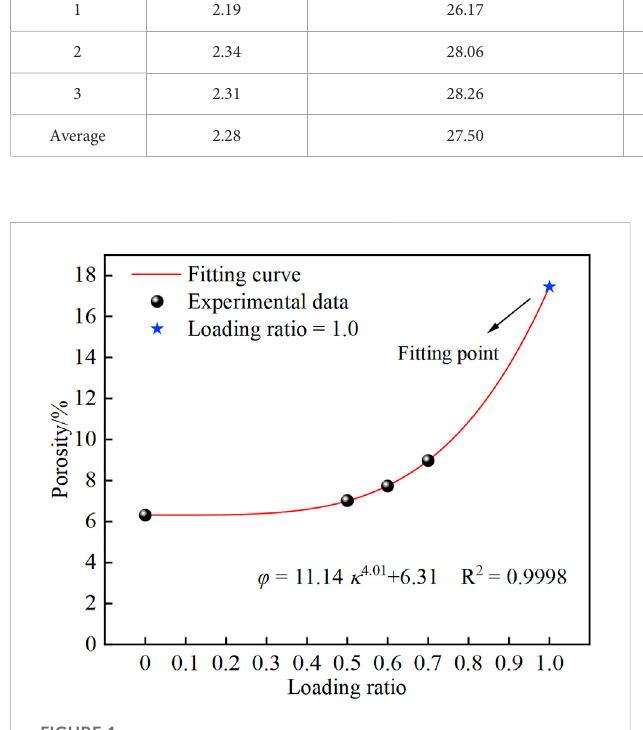
FIGURE 1 Variation of the porosity of sandstone specimens with the loading ratio.